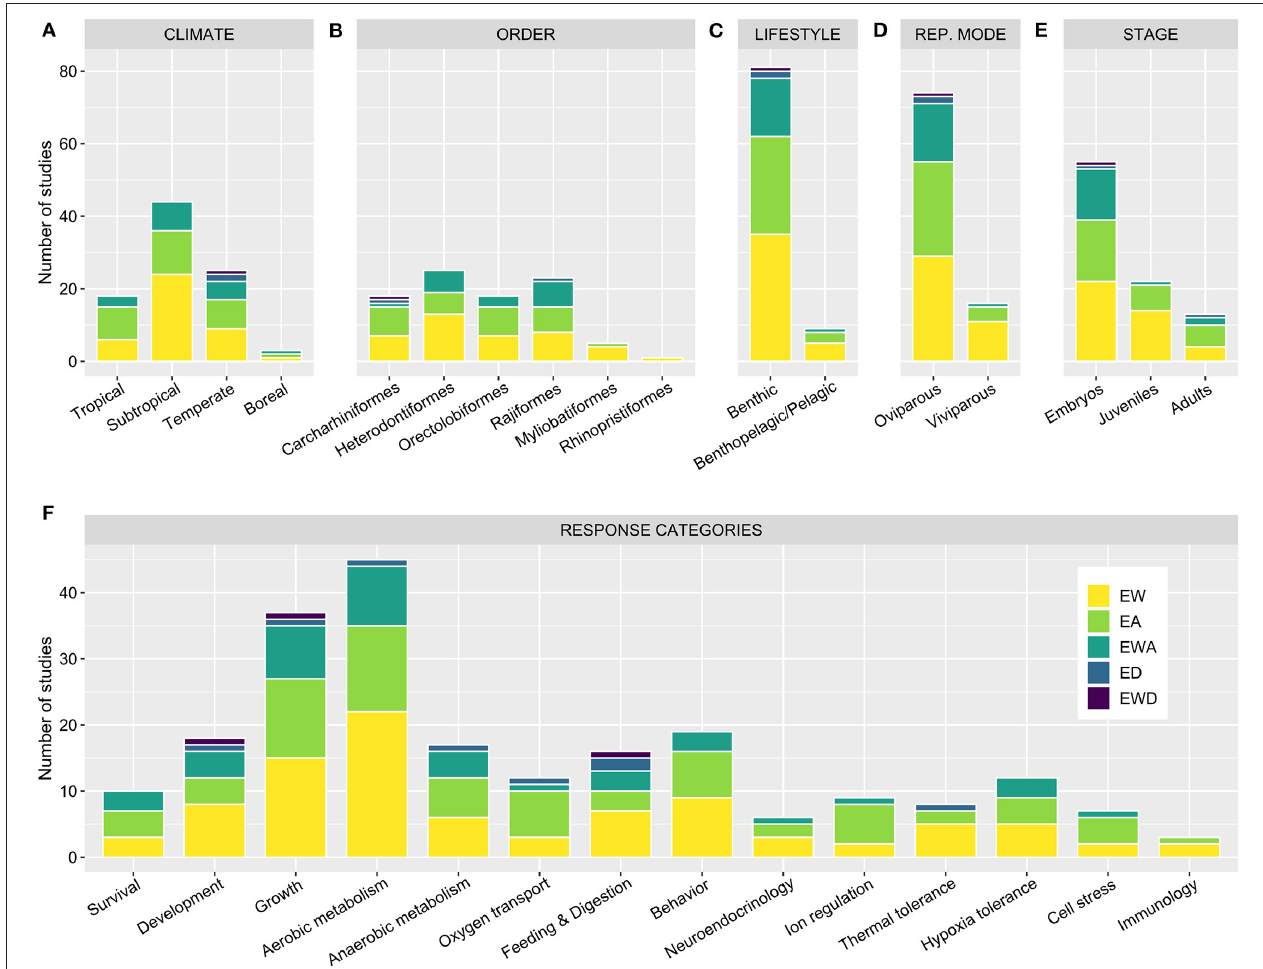
FIGURE 2 | Number of suitable studies assessing each factor [experimental warming (EW), acidification (EA), deoxygenation (ED), along with their combinations (EWA and EWD)] across different attributes of the model organisms used, namely their climate (A) , order (B) , lifestyle (C) , reproduction mode (D) , and life stage (E) , as well as (F) the response categories